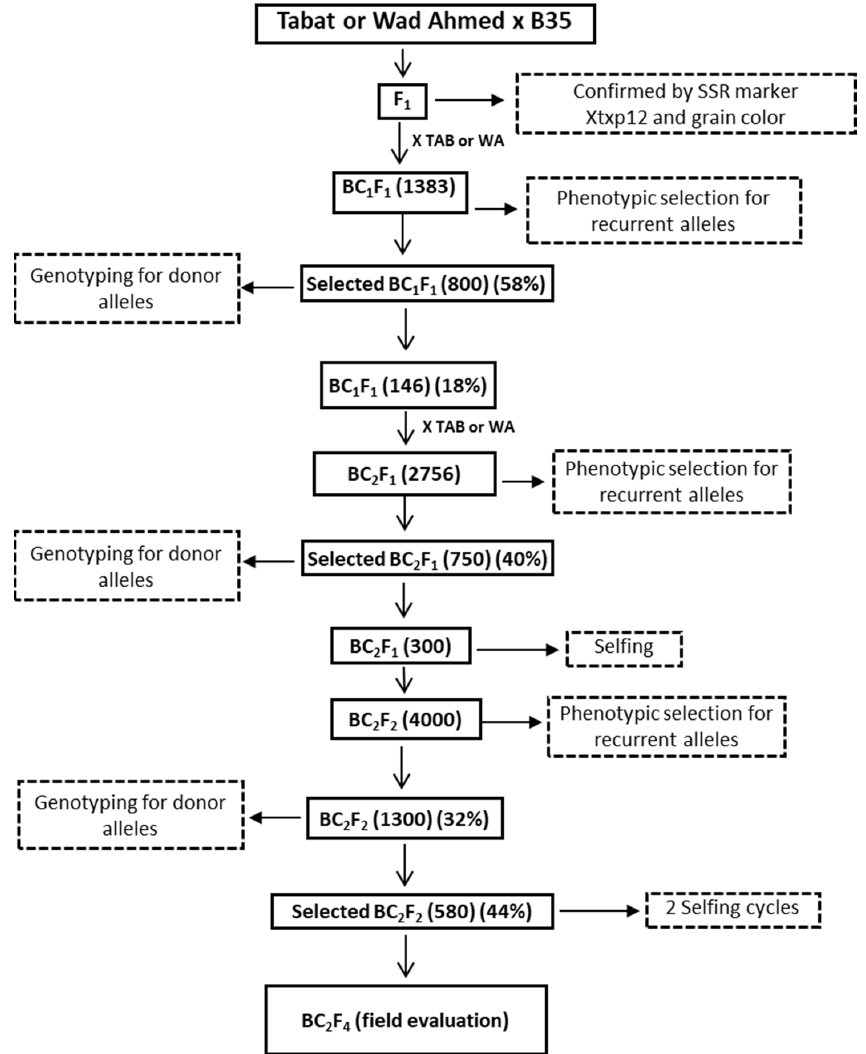
Figure 1. Combined marker-assisted backcrossing (C_MAB) steps used to transfer the stay-green trait from B35 into ‘Tabat’ (TAB) and ‘Wad Ahmed’ (WA) backgrounds. trait from B35 into ‘Tabat’ (TAB) and ‘Wad Ahmed’ (WA)